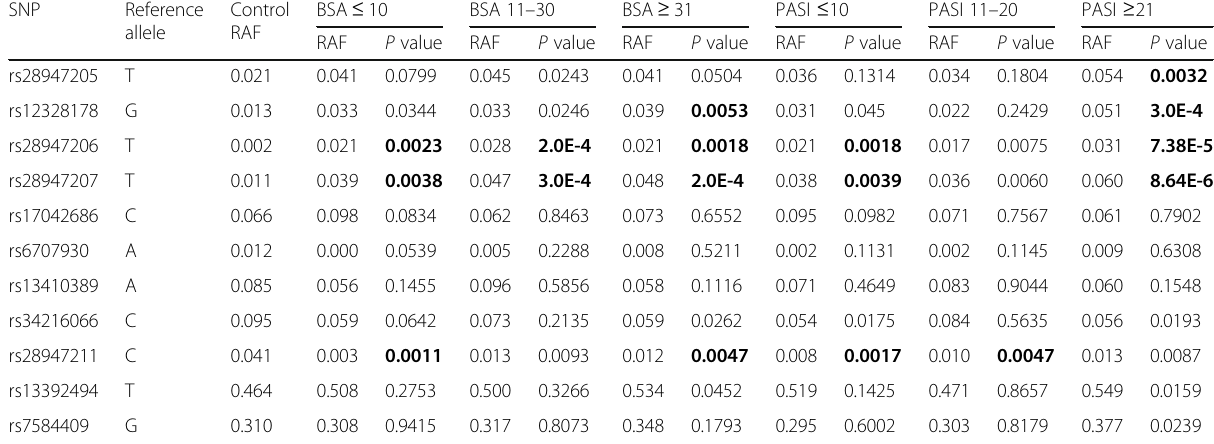
Table 3 Results of allelic association analysis